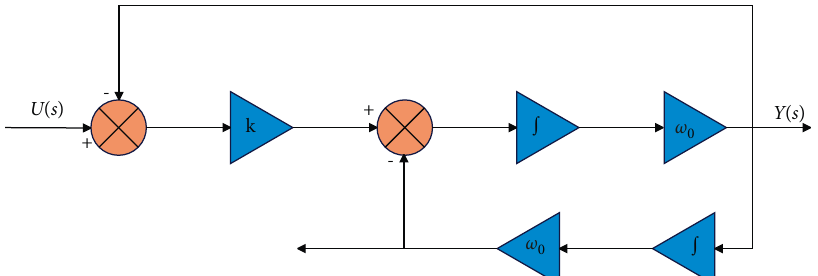
Figure 2: Structure block diagram of band-pass filter implemented by SOGI.